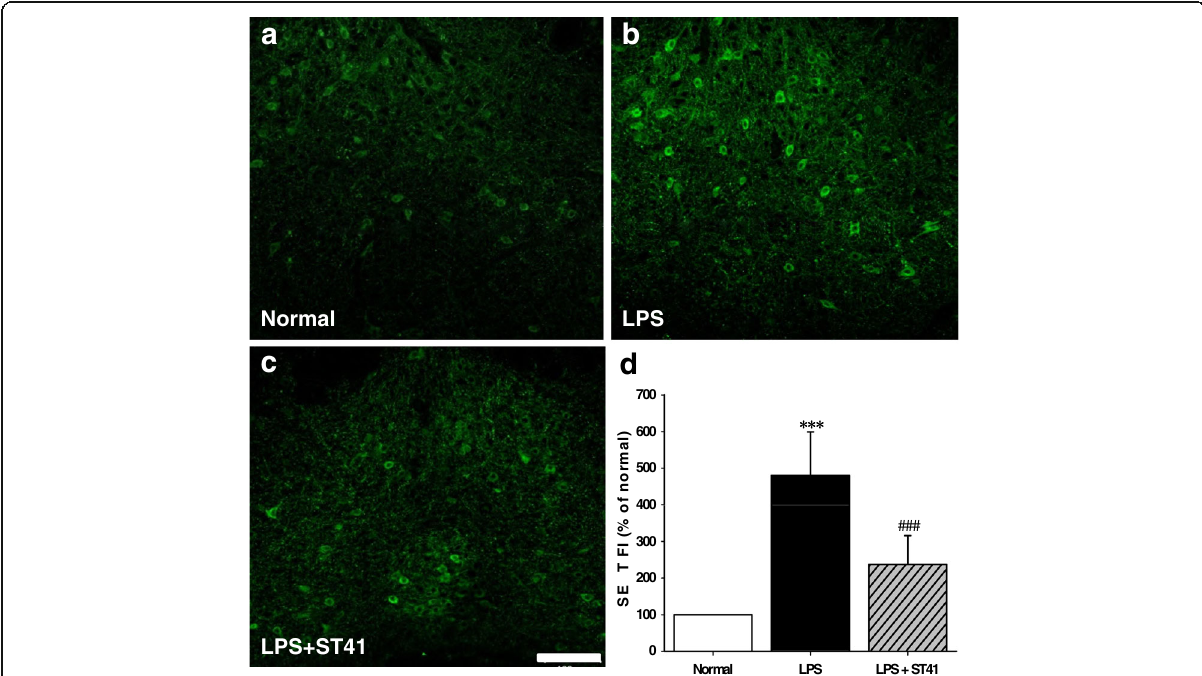
Fig. 5 Effect of acupuncture on SERT expression in the DRN. a-c Representative images of SERT expression in the DRN. d Summary of SERT fluorescence intensity (FI, D) in the DRN following LPS administration. Data are expressed as percentage of control (normal). Acupuncture at ST41 markedly decreased SERT expression produced by LPS in the DRN. ** P < 0.01 and *** P < 0.001 vs. control, ### P < 0.001 vs. LPS, n = 3 – 4 per group. Scale bar = 50 μ